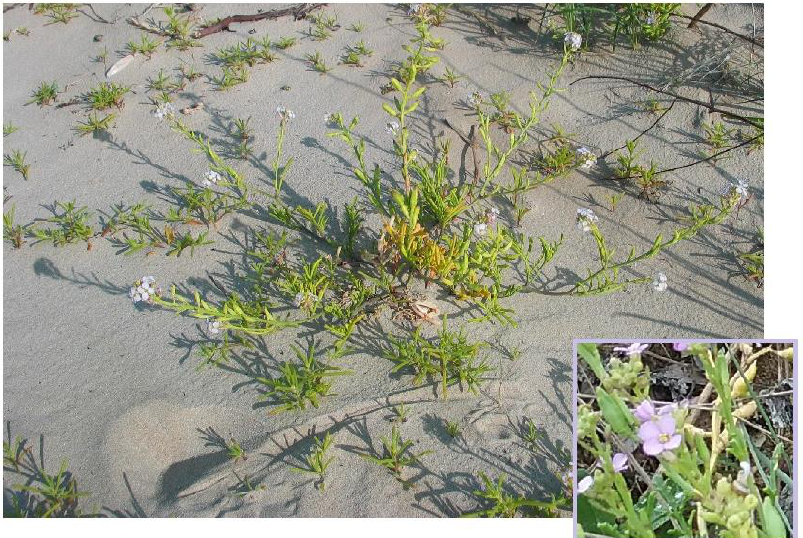
Figure 9. Cakile